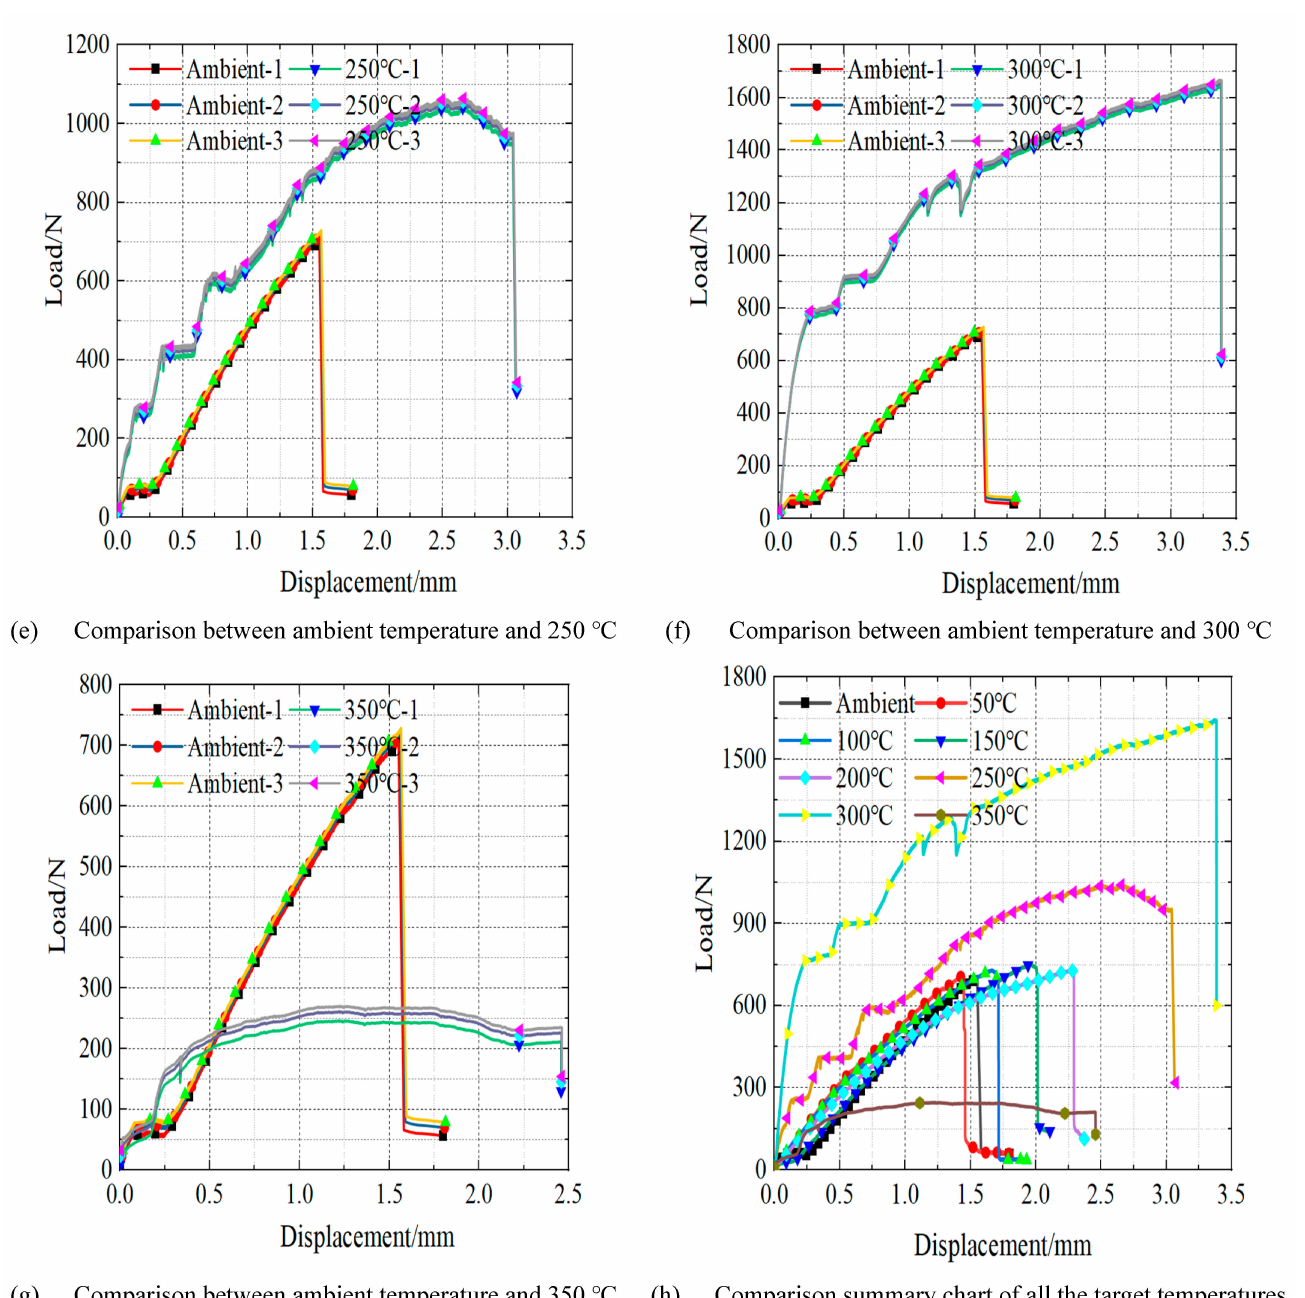
Figure 3. Load − displacement